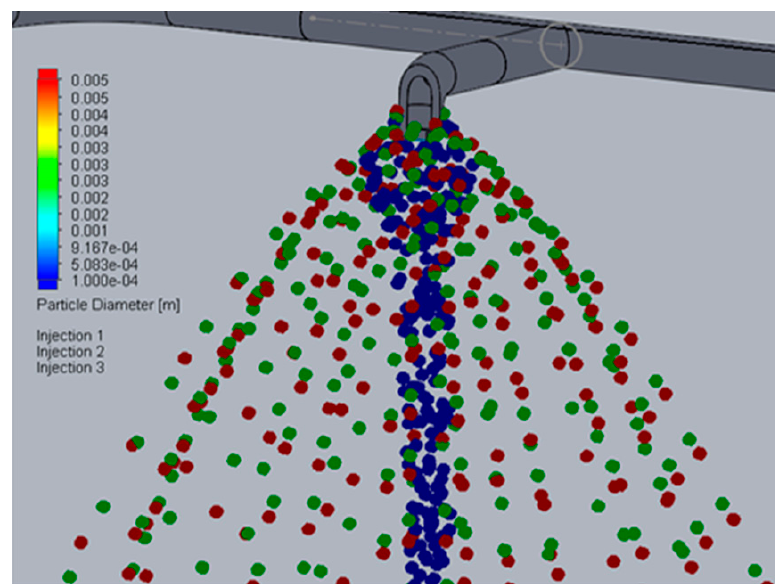
Figure 5. Visualizing the distribution pattern of liquid droplets.